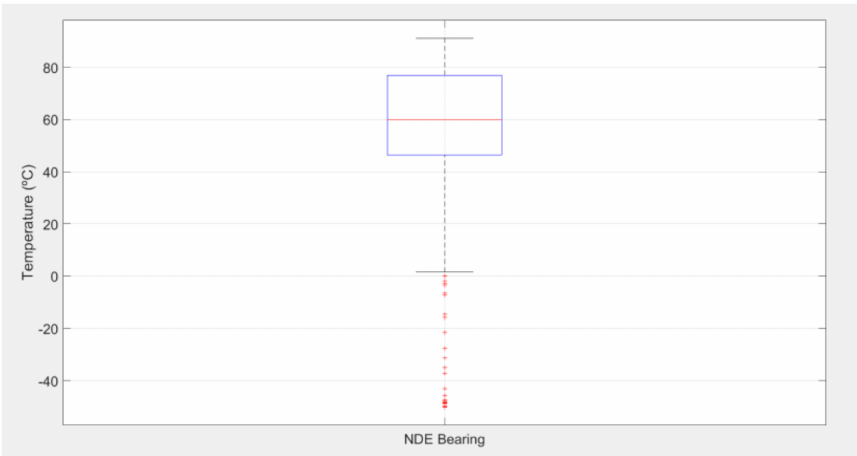
Figure 1. Boxplot-type representation of the temperature of the NDE